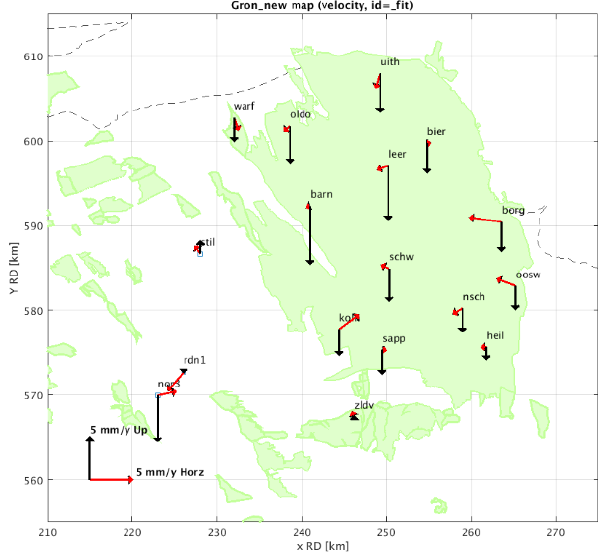
Figure 2. Horizontal and vertical deformation in mmyr − 1 for the IGRS that are operational more than 1 year, from start of deploy- ment until mid 2019. The green areas depict the gas fields. The sta- tion “nor3” contains a fluctuating component due to gas injection and